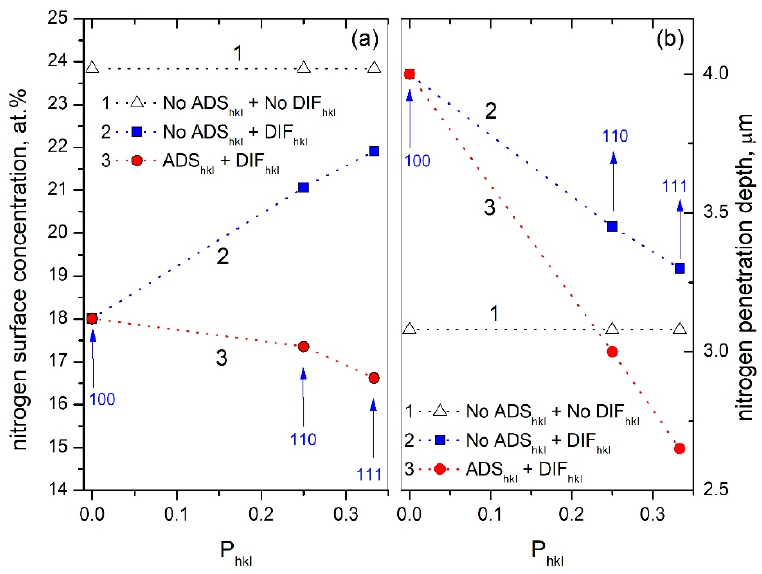
Figure 3. Dependencies of nitrogen surface concentration ( a ) and penetration depth ( b ) on parameter P hkl calculated for three different cases: (1) isotropic surface processes and isotropic diffusion (No ADS hkl + No DIF hkl ), (2) isotropic surface processes and anisotropic diffusion (No ADS hkl + DIF hkl ), and (3) anisotropic surface processes and anisotropic diffusion (ADS hkl + DIF hkl ).